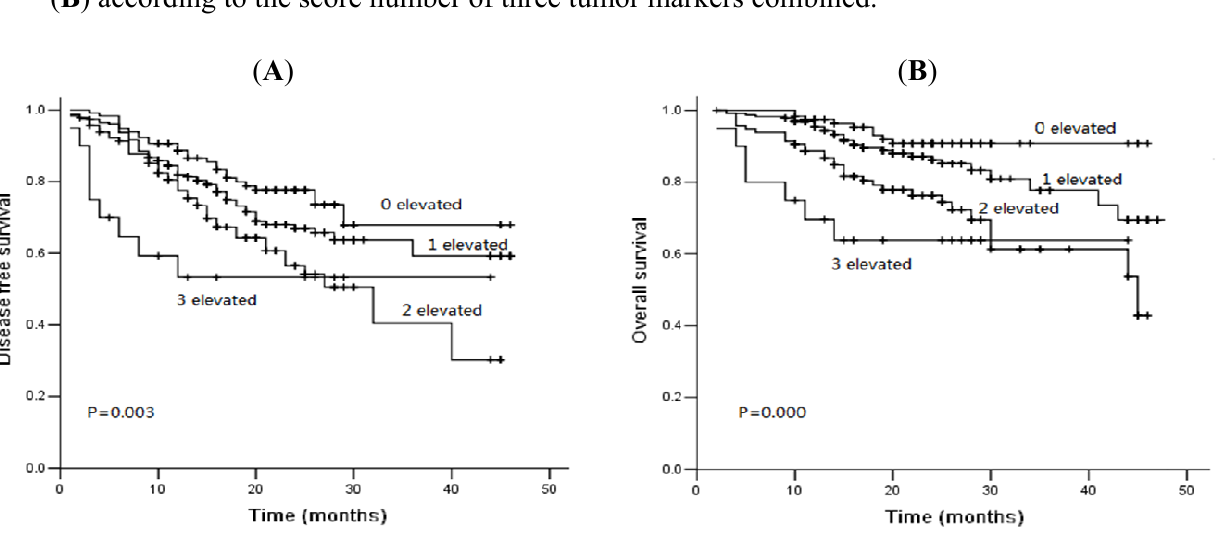
Figure 5. Kaplan-Meier disease-free survival curves ( A ) and overall survival curves ( B ) according to the score number of three tumor markers